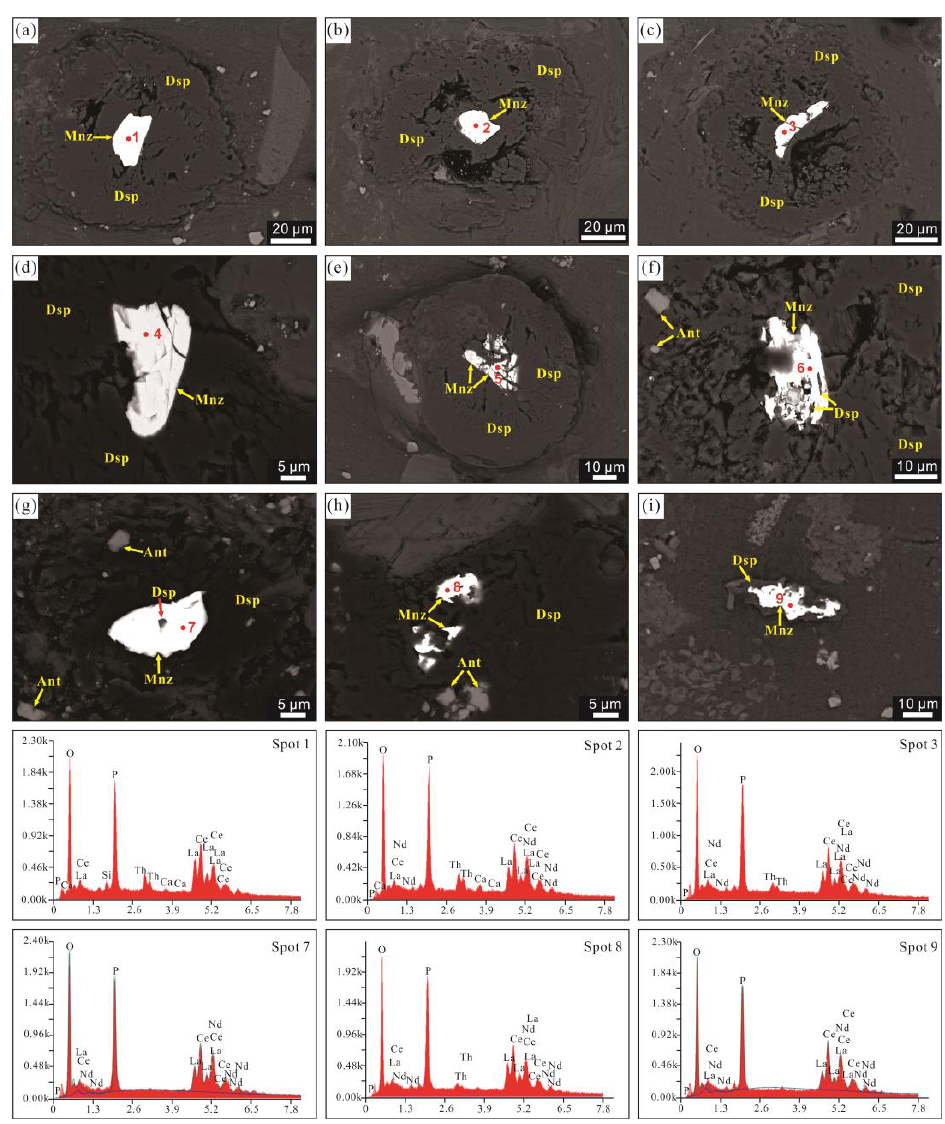
Figure 9. SEM backscattered electron (BSE) images of monazite and representative EDS spectra. ( a , b ) Detrital monazite presents subhedral crystals with rounded margins; ( c ) detrital monazite presents anhedral crystals with rounded margins; ( d , e ) detrital monazite presents discontinuous fragments; ( f – i ) authigenic monazite showing the coexistence of irregular monazite, cryptocrystalline diaspore, and euhedral anatase.